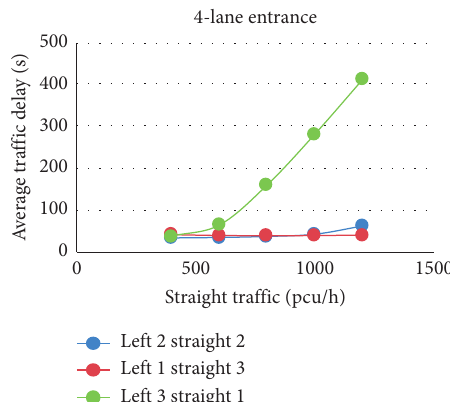
Figure 8: Change chart of the straight direction delay under different combinations of lanes on four entrance lanes.